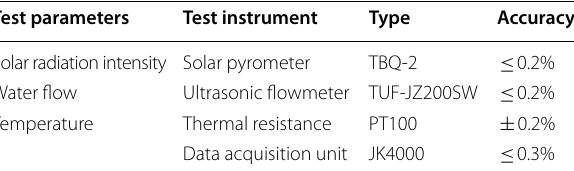
Table 1 Test instrument, type and parameter Test parameters Test instrument